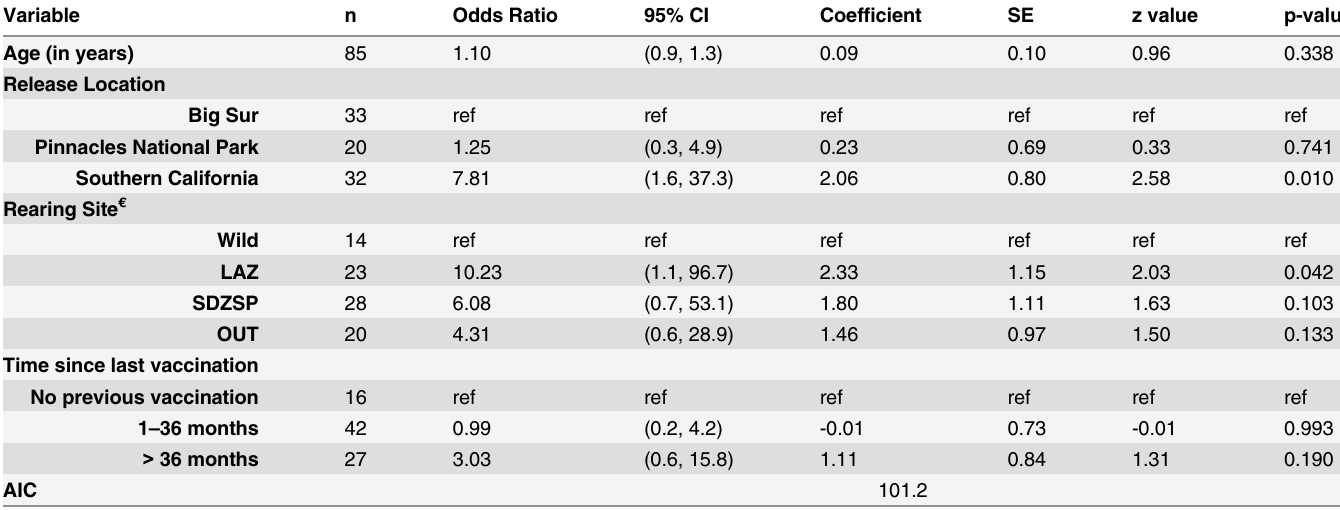
Table 3. Multivariable logistic regression model evaluating the association between potential predictors and West Nile virus serostatus in free-fly- ing California condors. Variable